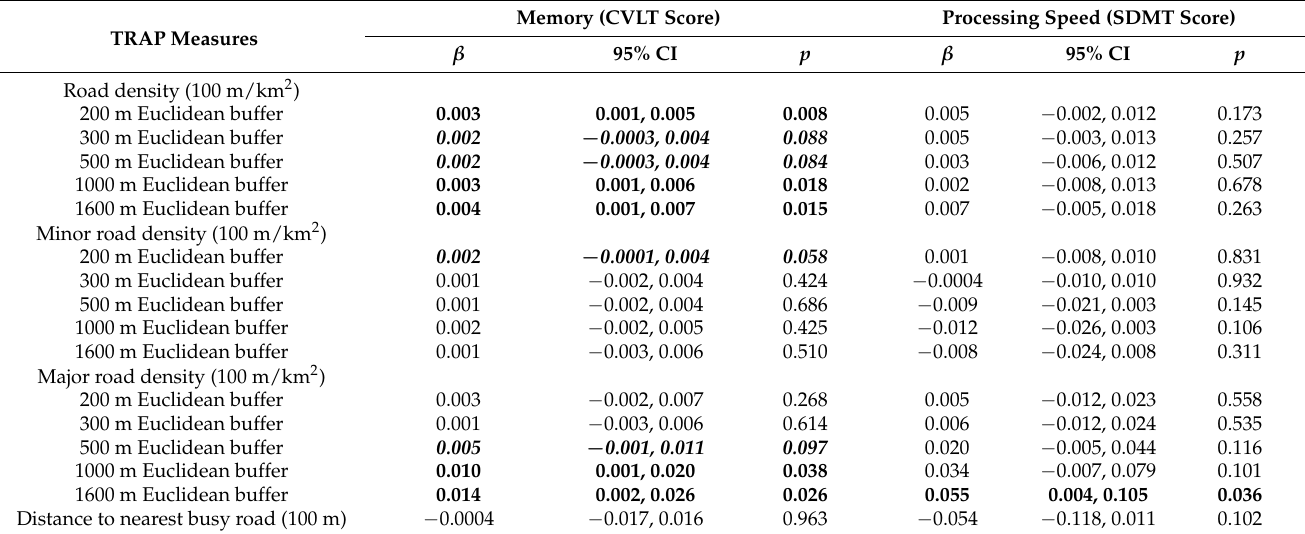
Table 3. Associations of transport-related air pollution (TRAP) measures with cognitive function (multiple imputation analyses; all participants n = 4141).